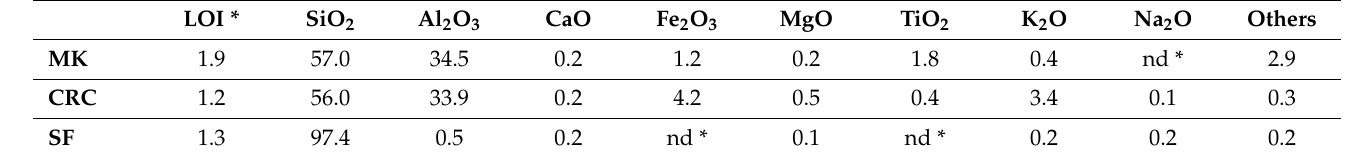
Table 3. The chemical composition of the raw materials (% by